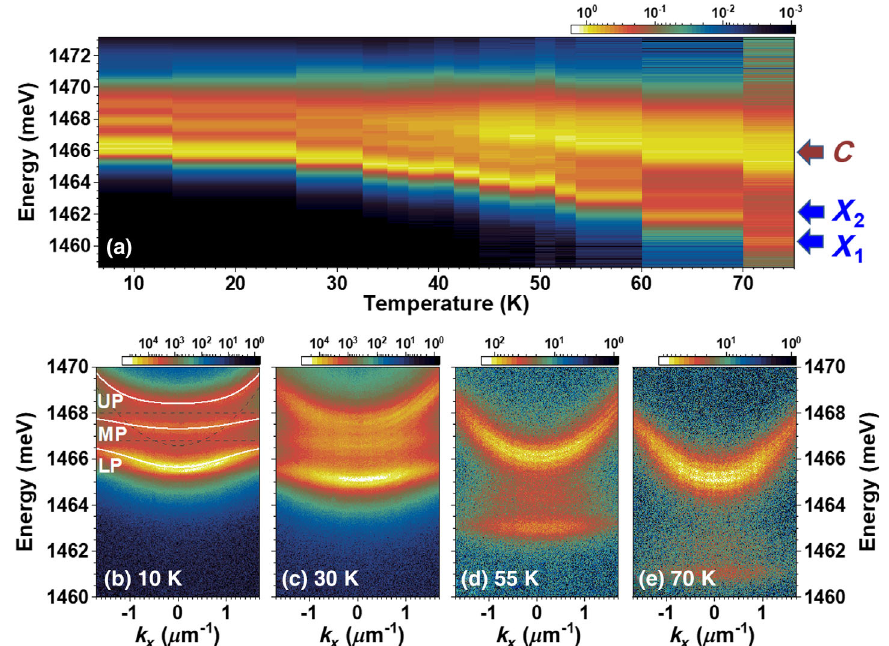
FIG. 9. Temperature dependence of the PL of the hybrid MC (sample A ). (a) Temperature dependence of the PL spectrum. X 1 and X 2 are excitonic resonances of the coupled InGaAs QWs, which couple to the photonic ( C ) mode of the MC to form the lower (LP), middle (MP), and upper (UP) states at low temperatures. Momentum-resolved PL at (b) 10, (c) 30, (d) 55, and (e) 70 K. Below 50 K, the system is in the strong-coupling regime. The solid lines in (e) are three coupled oscillator fits to the data. The dashed lines are bare energies. The ¼ 2 (cid:2) 0 . 3 fitted Rabi splitting energy is Ω Rabi